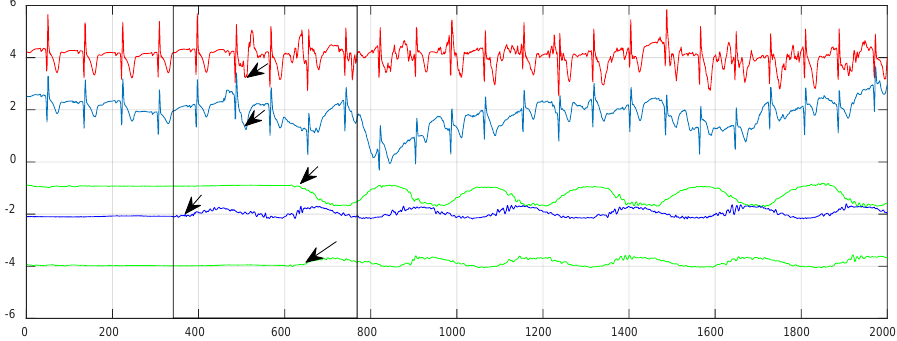
Figure 3. Signal synchronization (from top to bottom: Ag / AgCl electrode signal, fabric electrode signal, right, middle, and left inertial module x-axis signal).